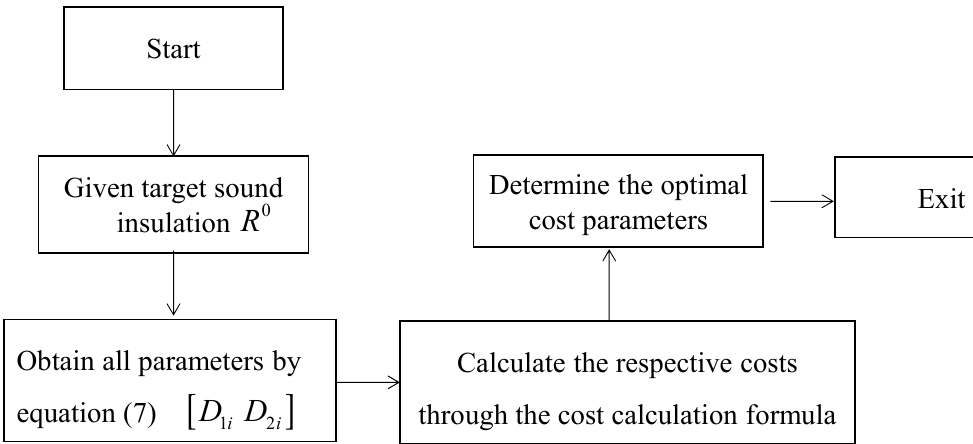
Figure 5. Optimal cost calculation model diagram.